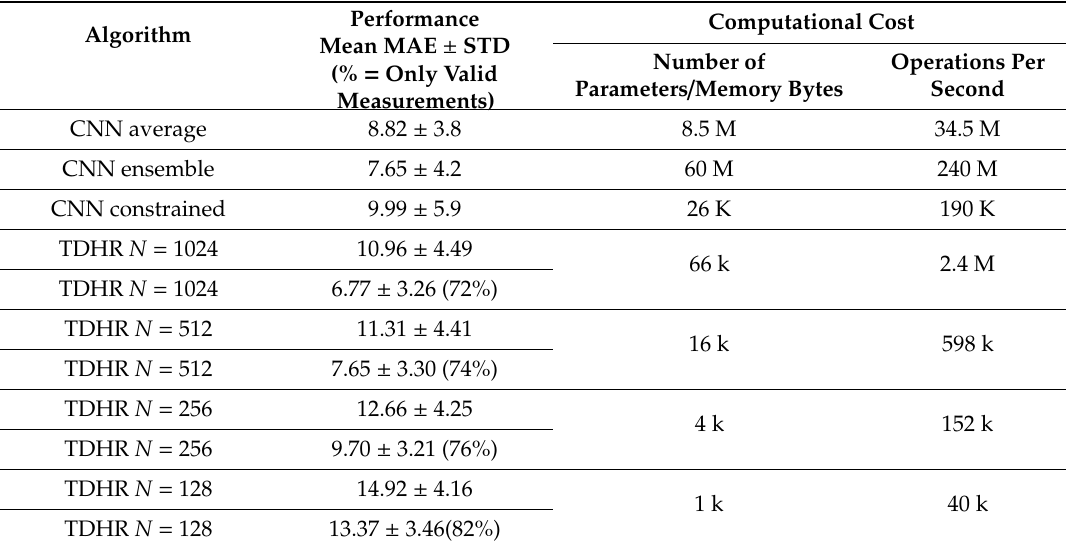
Table 2. Comparison of the performance versus computational cost of the TDHR algorithm and the algorithms from the literature. The computational cost of the TDHR algorithm was calculated as the number of arithmetical operations and the number of memory bytes needed for algorithm realization in a